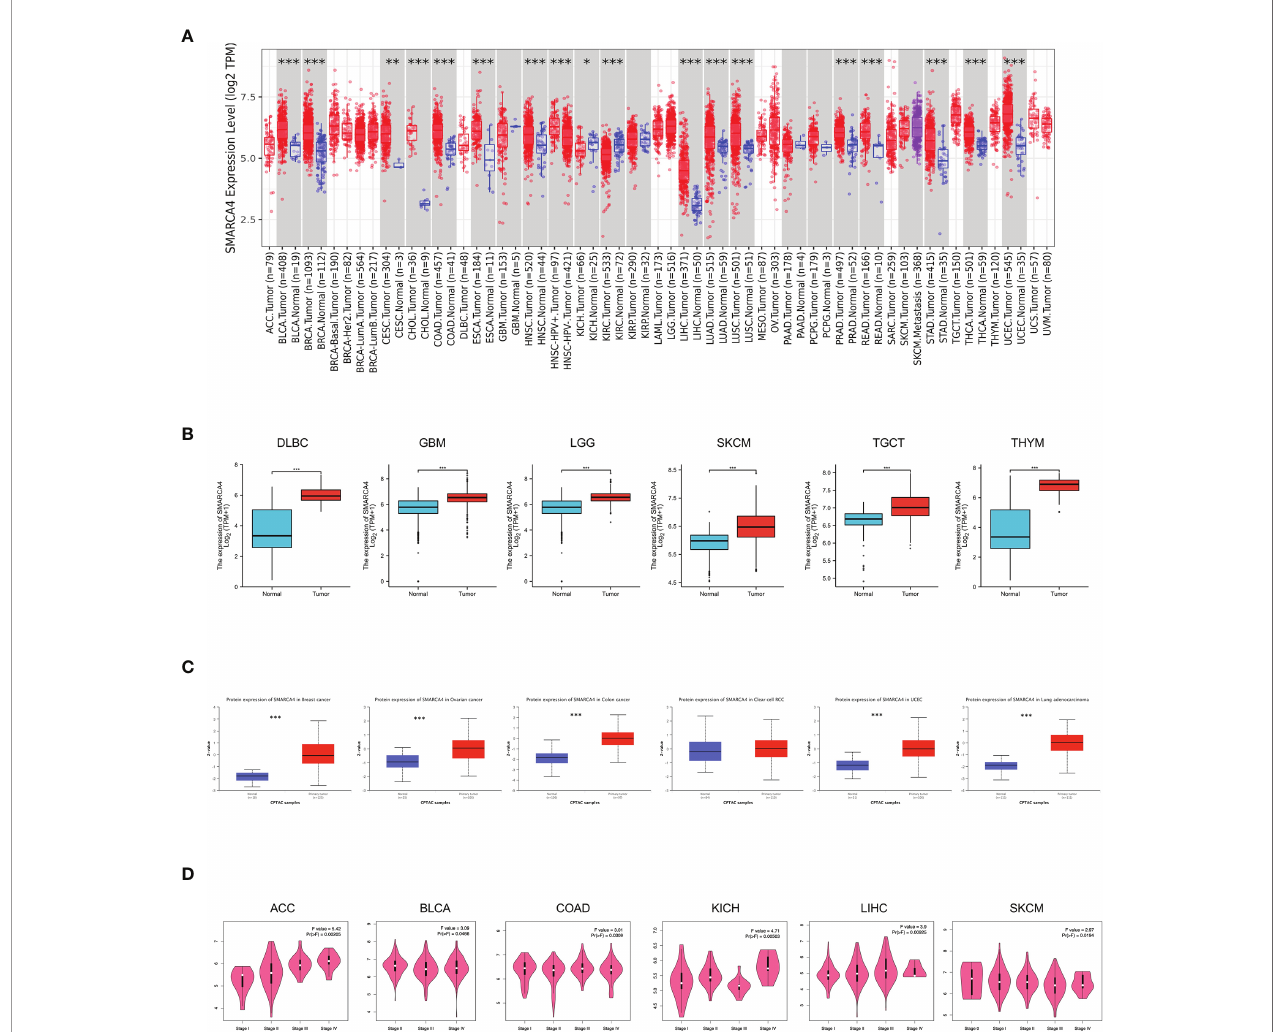
FIGURE 1 | Expression level of SMARCA4 gene in different tumors and pathological stages. (A) The expression status of the SMARCA4 gene in different cancers or speci fi c cancer subtypes was analyzed through TIMER2. * p < 0.05; ** p < 0.01; *** p < 0.001. (B) For the type of DLBC, GBM, LGG, SKCM, TGCT, and THYM in the TCGA project, the corresponding normal tissues of the GTEx database were included as controls. The box plot data were supplied. ** p < 0.01. (C) Based on the CPTAC dataset, we also analyzed the expression level of SMARCA4 total protein between normal tissue and primary tissue of breast cancer, ovarian cancer, colon cancer, clear cell RCC, and UCEC. *** p < 0.001. (D) Based on the TCGA data, the expression levels of the SMARCA4 gene were analyzed by the main pathological stages (stages I, II, III, and IV) of ACC, BLCA, COAD, KICH, LIHC, and SKCM. Log2 (TPM +1) was applied for log